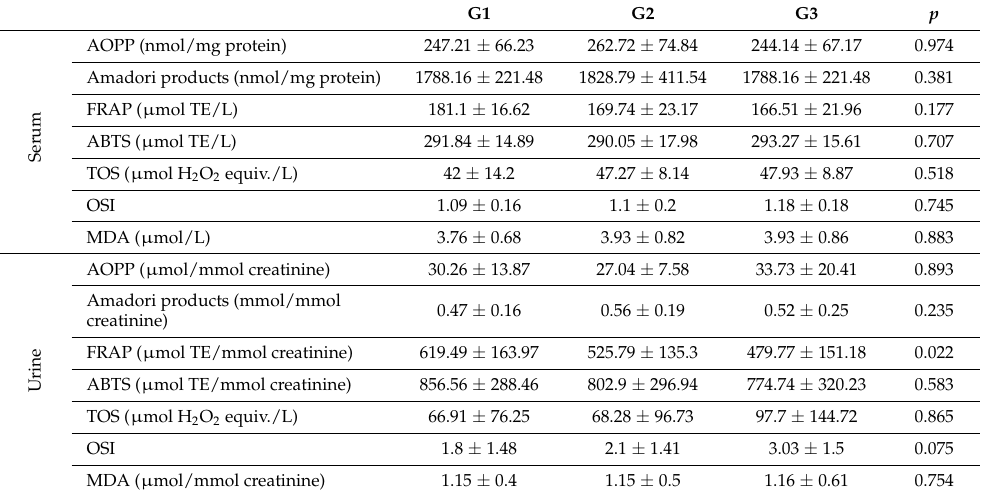
Table 4. Markers of oxidative stress in participants with bladder cancer depending on the cancer grading *.